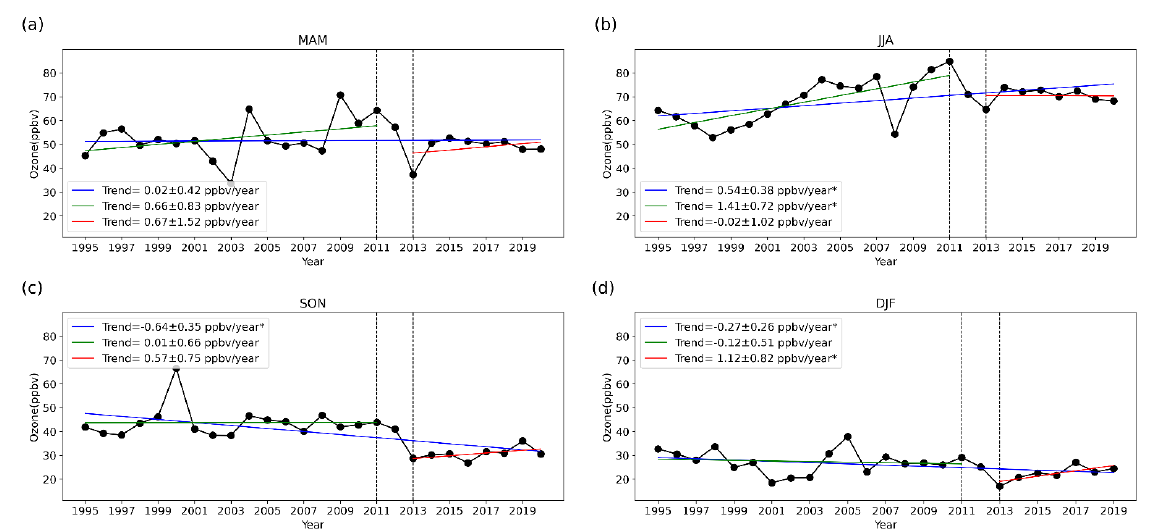
Figure 8. Beijing’s surface ozone mixing ratio in ( a ) spring (MAM), ( b ) summer (JJA), ( c ) autumn (SON), and ( d ) winter (DJF). The solid blue line, green line, and red line estimate the linear trends during 1995–2020, before 2011 and after 2013. The trends with “*” passed the 95 % significance test. Table 1. The linear trends (ppbv year −1 ) of Beijing surface ozone mixing ratio in different periods and different seasons. The trends with “*” passed the 95 % significance test.